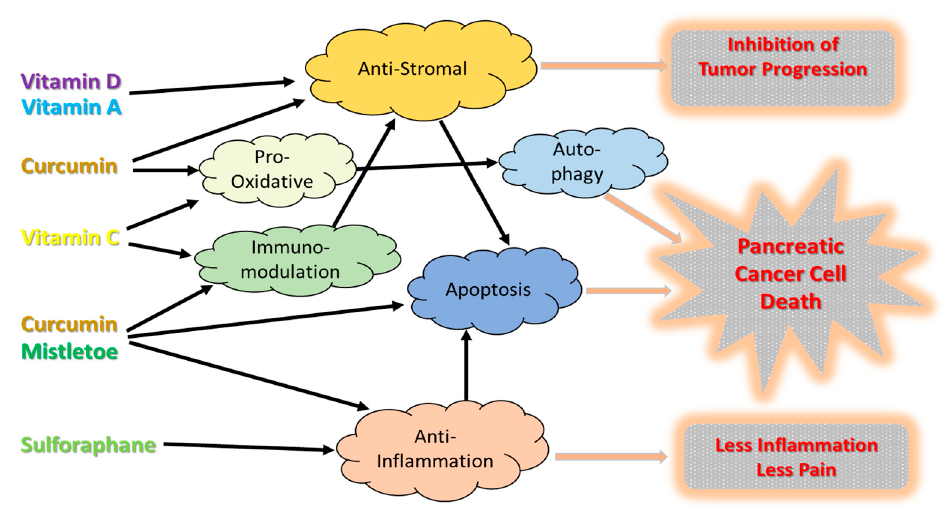
Figure 2. Mechanisms of phytochemicals in PC treatment.